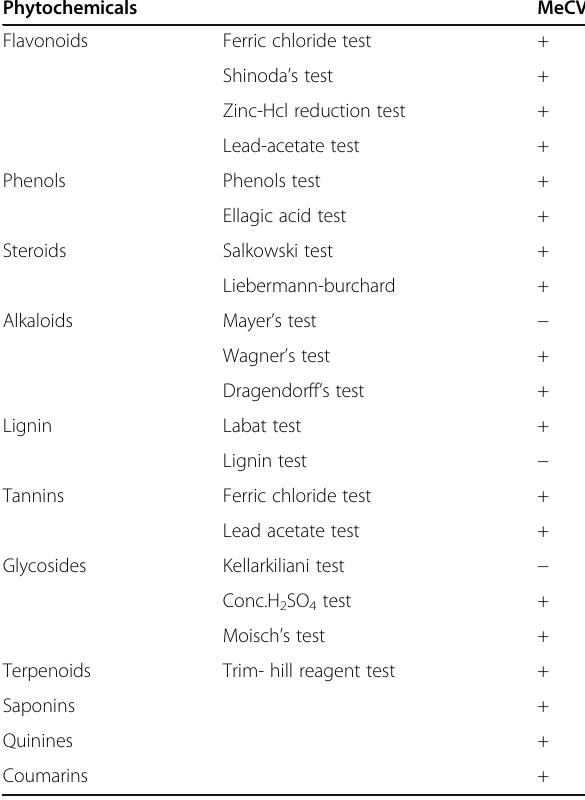
Table 1 Preliminary phytochemical screening of